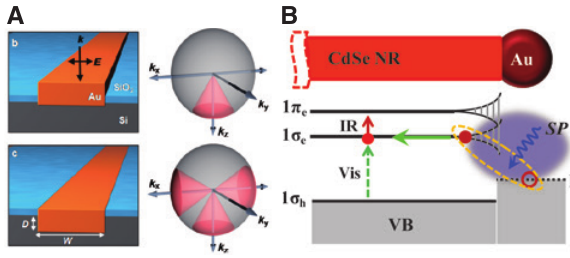
Figure 7: Improving the hot electron transfer efficiency. (A) Embedding plasmonic nanostructures provides more electron escape cones than planar devices. (B) Electronic band structure of a CdSe-Au interface showing the plasmon-induced interfacial charge- transfer transition. The plasmon decay directly creates an electron in the conduction band of the semiconductor and a hole in the metal. Figures adapted with permission from: (A) Ref. [86], ©2013 American Chemical Society; (B) Ref. [157], ©2015 American Associa- tion for the Advancement of